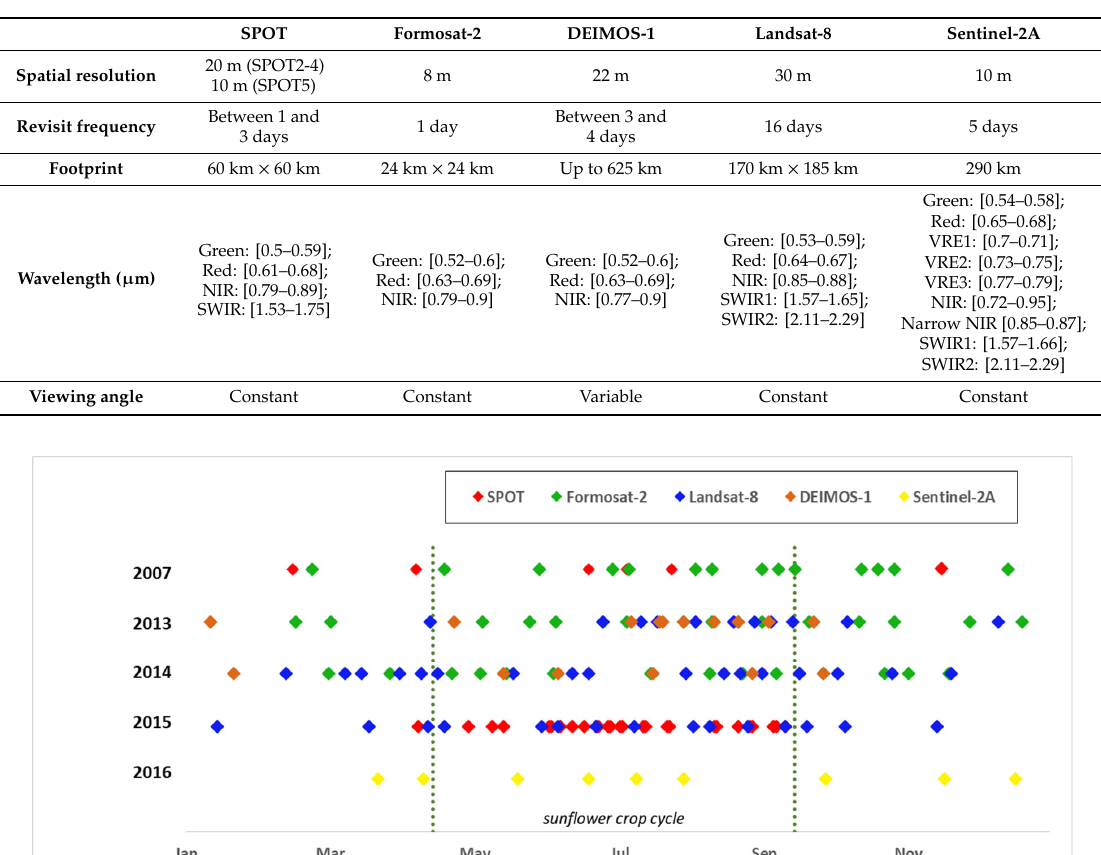
Table 4. Main characteristics of the satellite sensors used in this study and the bands used to derive the green area index (GAI).